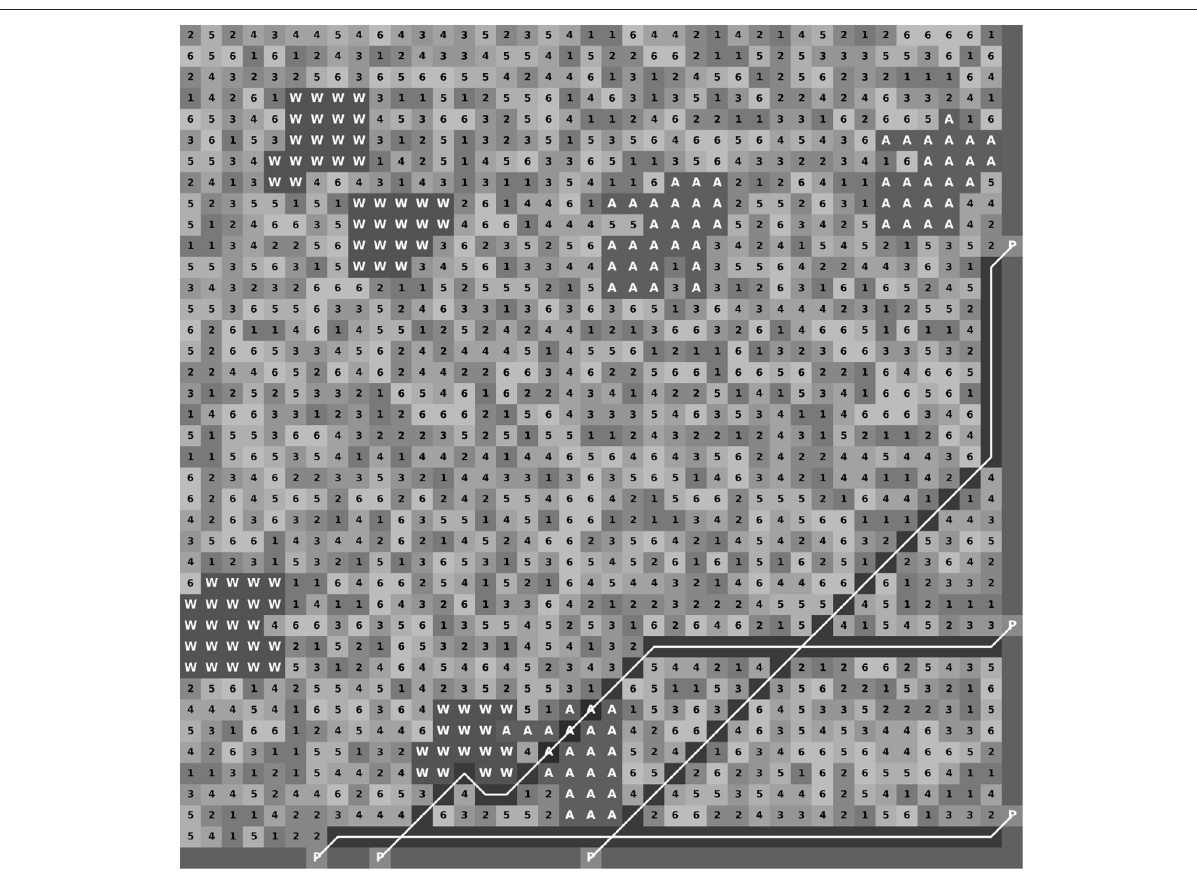
FIGURE 5 | A sample